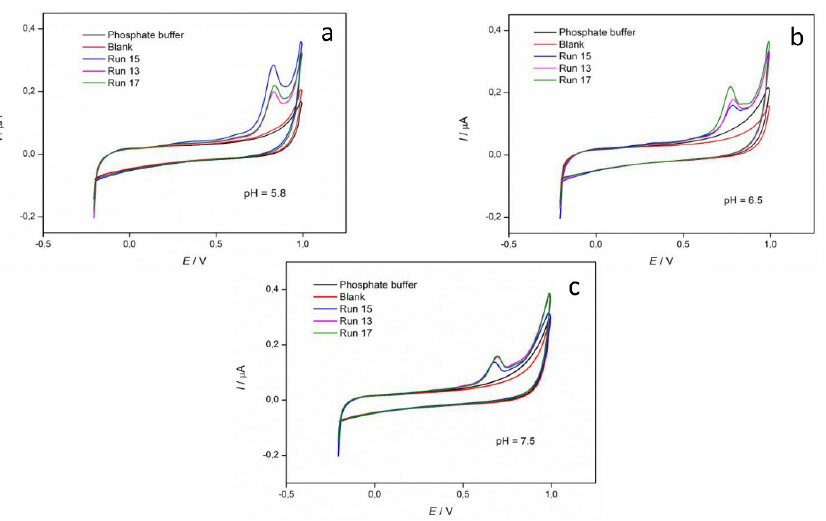
Figure 7. Cyclic voltammograms of calcium oxalate precipitate (Blank ( ― ), Run 15 ( ― ), Run 13 ( ― ), Run 17 ( ― )) in phosphate buffer solutions pH = 5.8 ( a ), 6.5 ( b ) and 7.5 ( c ). Scan rate 100 mV/s.